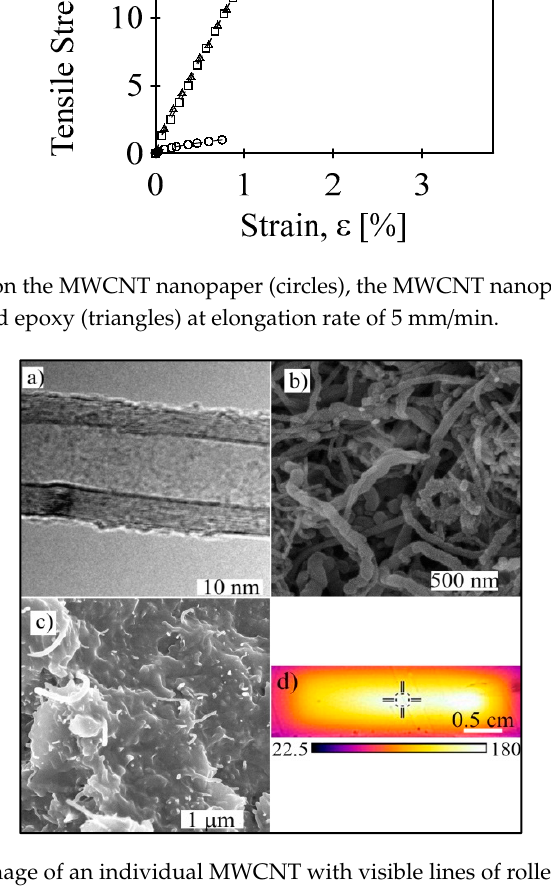
Figure 4. Tensile tests on the MWCNT nanopaper (circles), the MWCNT nanopaper/epoxy composite (squares), and the cured epoxy (triangles) at elongation rate of 5